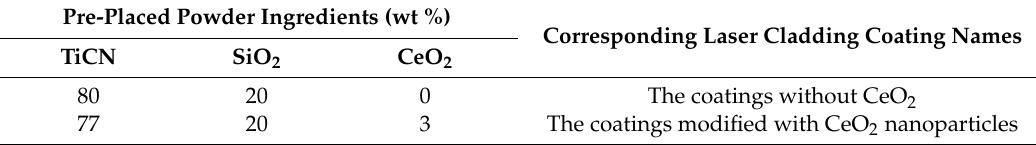
Table 1. The ingredients of the pre-placed powder and the corresponding laser cladding coating names. Pre-Placed Powder Ingredients (wt %)